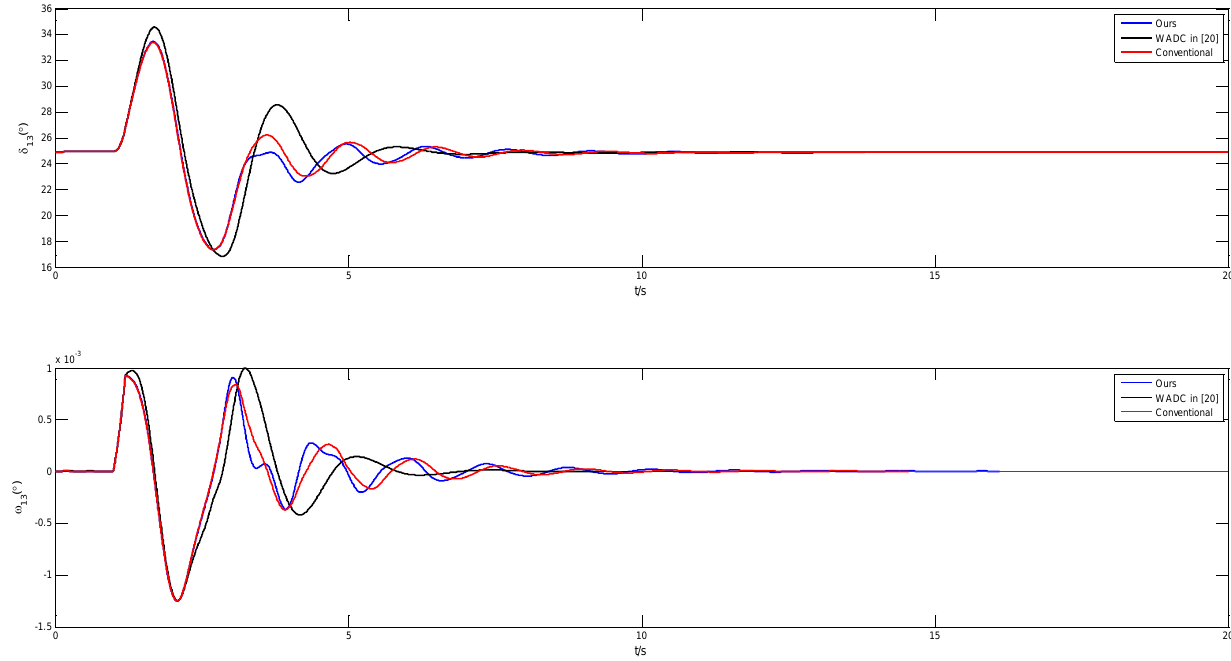
Figure 12. Response of the system in Scenario 1 when 𝜌 = 0 .2.